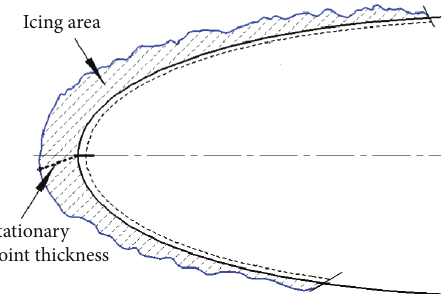
Figure 17: Typical characteristics of icing shape.